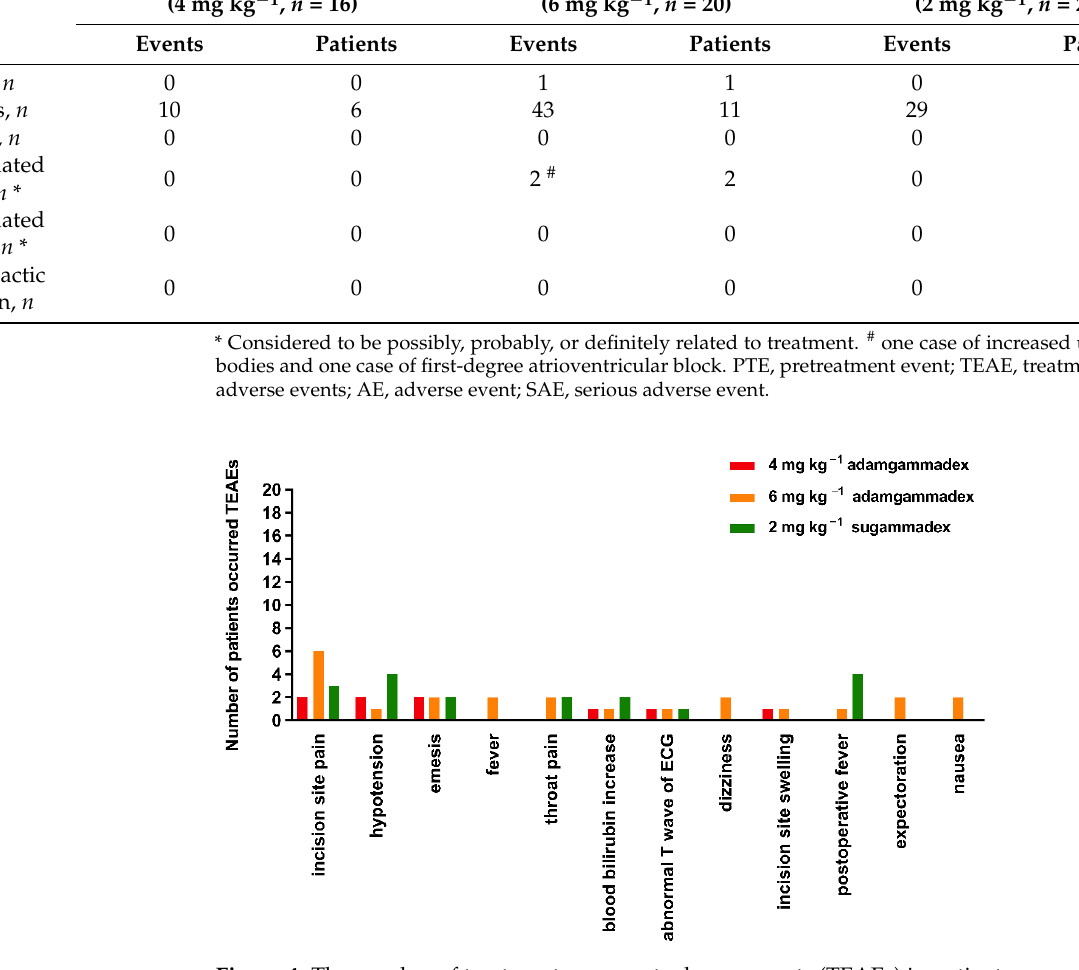
Table 2. Adverse events by dose group: safety population set. Table 3. The coagulation function.